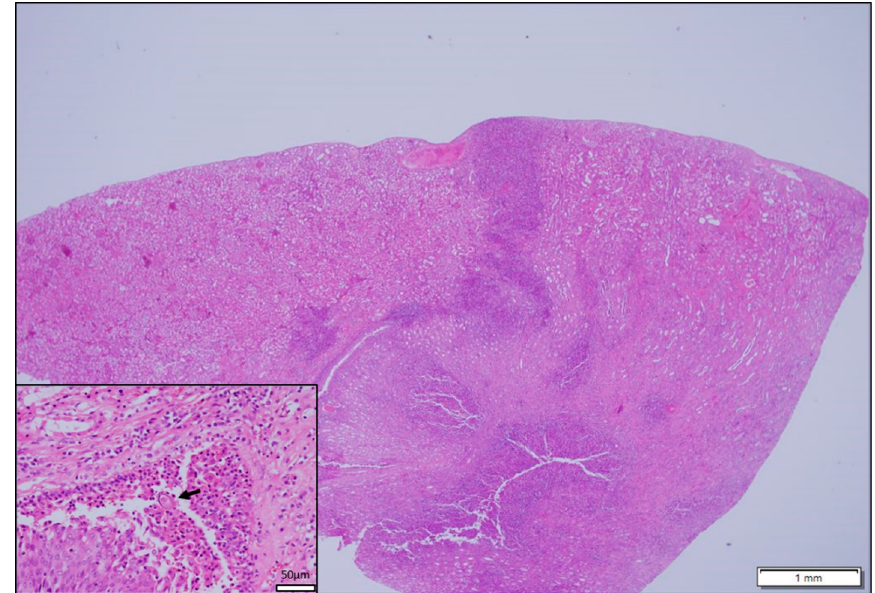
Figure 4. Mongoose 22. Kidney. Chronic active pyelonephritis. (Inset) Mongoose 22. Capillaria -type egg (arrow) in lumen of renal pelvis with inflammatory cells.